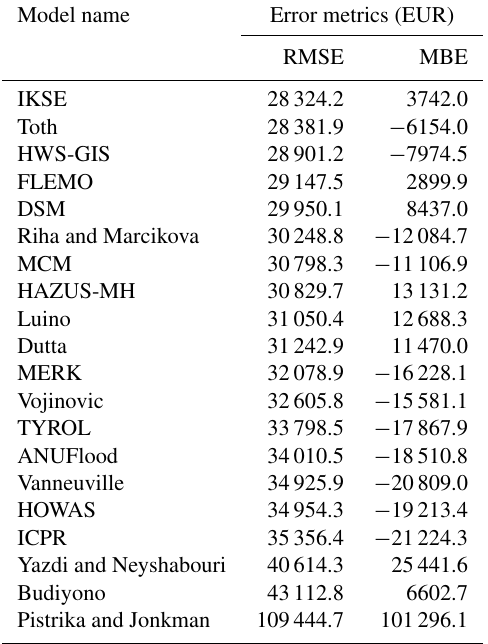
Table 4. Results of individual model applications in the Caldogno case: root mean square error (RMSE) and mean bias error (MBE), sorted by